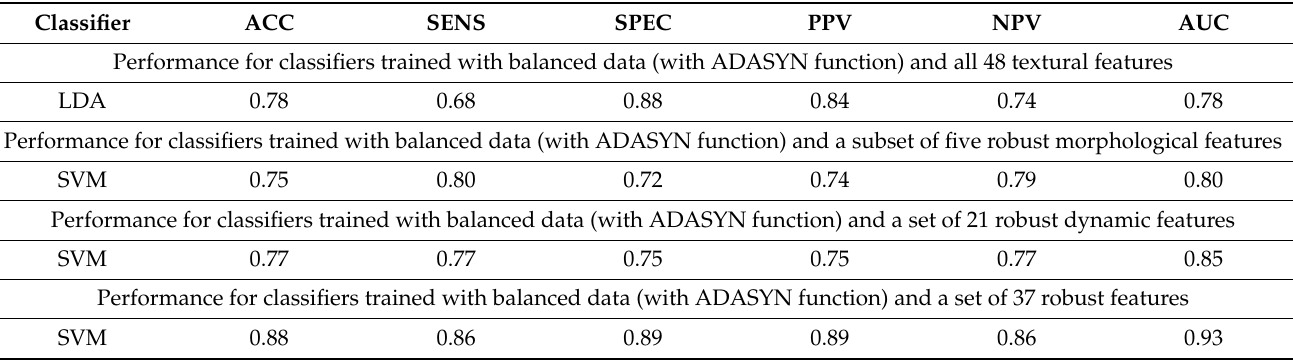
Table 6. Performance of the best classifiers using textural, morphological and dynamic features alone and then together. Classifier ACC SENS SPEC PPV NPV AUC